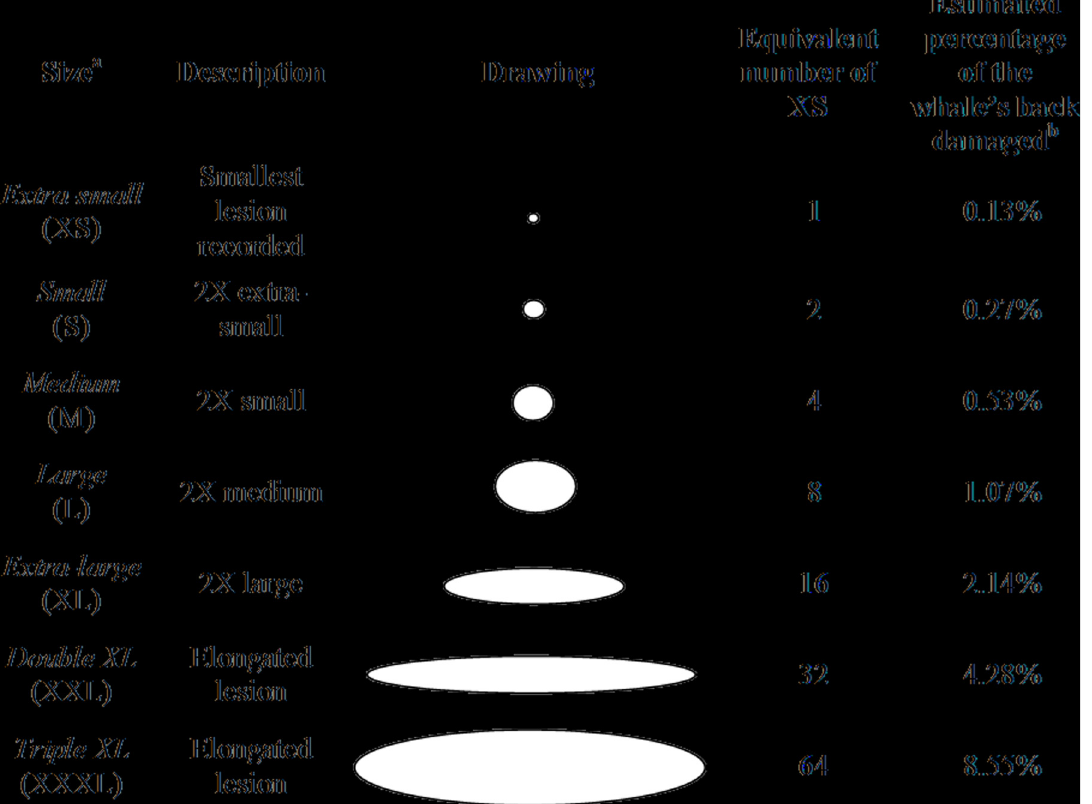
Fig 2. Sizes of gull lesions on southern right whales and their equivalent number of extra-small lesions. a Abbreviations: Extra-small (XS), Small (S), Medium (M), Large (L), Extra-large (XL), Double XL (XXL) and Triple XL (XXXL). b The total back area or TBA (100%) available for scoring extended from the fat roll (behind the blowholes) to the beginning of the tail stock and down the sides to the region of the back that is above the water or clearly visible through the water when the whale is close to the surface (see S1 Fig). See methods for a complete